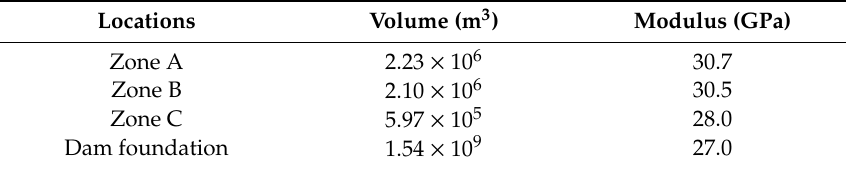
Table 6. Modulus of elasticity for main zones of Jinping-I